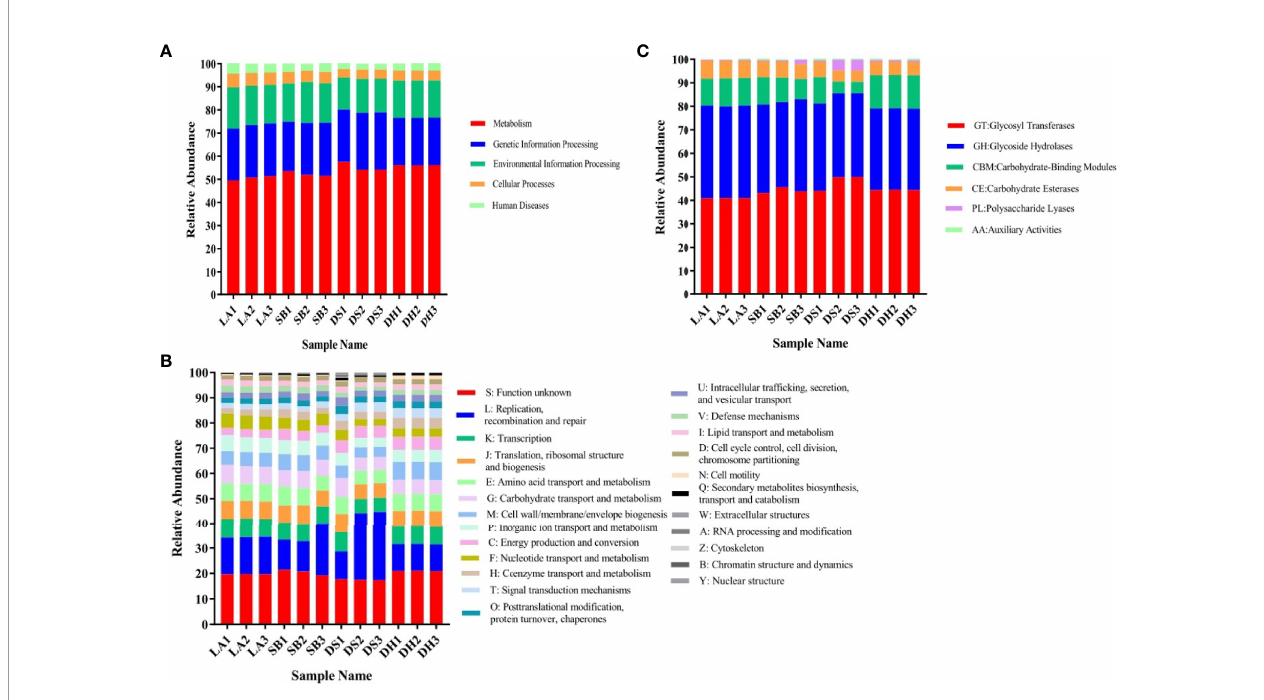
FIGURE 4 | Relative abundance based on level A hits in (A) KEGG, (B) eggNOG, and (C) CAZy functional categories in each sample.